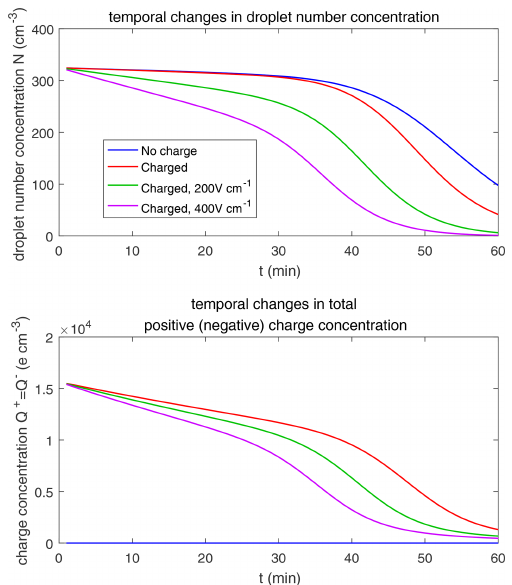
Figure 12. Temporal changes in droplet total number concentration and total charge content for ¯ r =